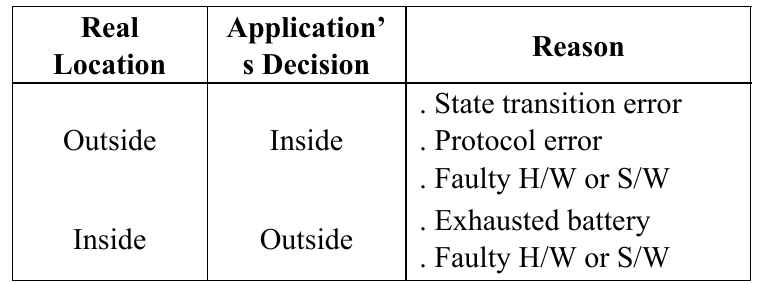
Table 1. Incorrect in/out